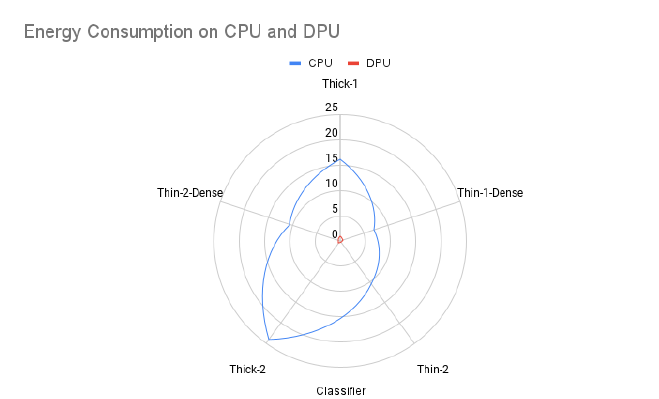
Figure 14. Gap between energy consumption on CPU and